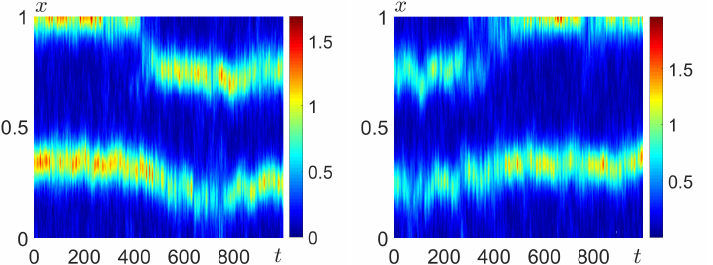
Figure 13. Bidirectional noise-induced transitions: 1.5 ↑→ 2 ↑ ( left ) and 2 ↑→ 1.5 ↑ ( right ), in Systems (1), (2) with a = d = e = 0.5, c = 1, D u = 5 × 10 − 4 , D v = 0.02, b = 1, ε =